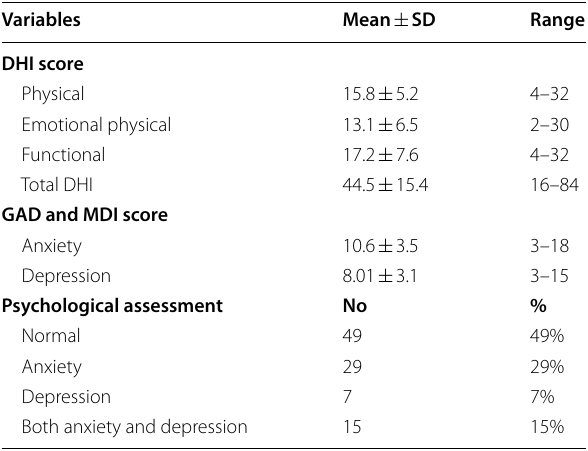
Table 2 Assessment of vestibular and psychological symptoms among the study group